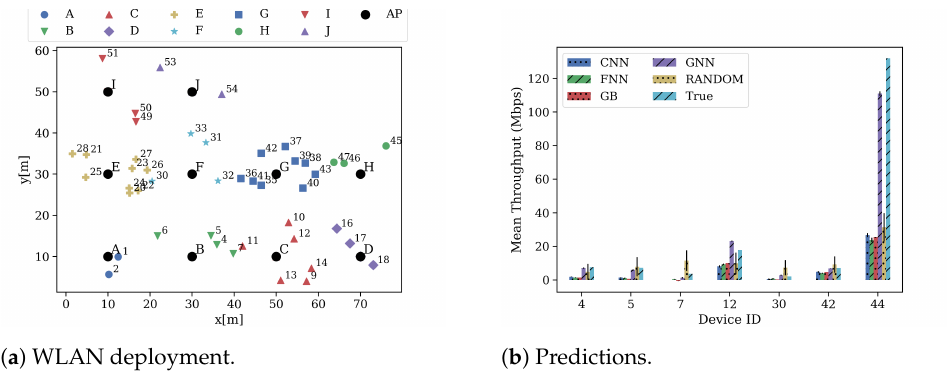
Figure 10. Deployment and predictions of some devices of test scenario